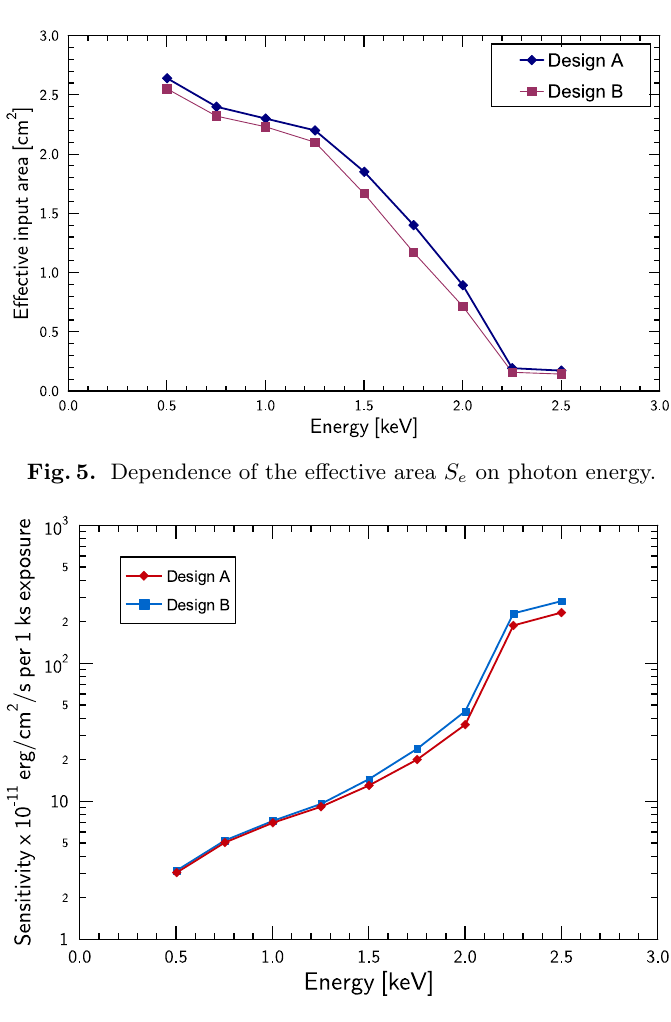
Fig. 6. Dependence of sensitivity per 1 ks exposure on photon